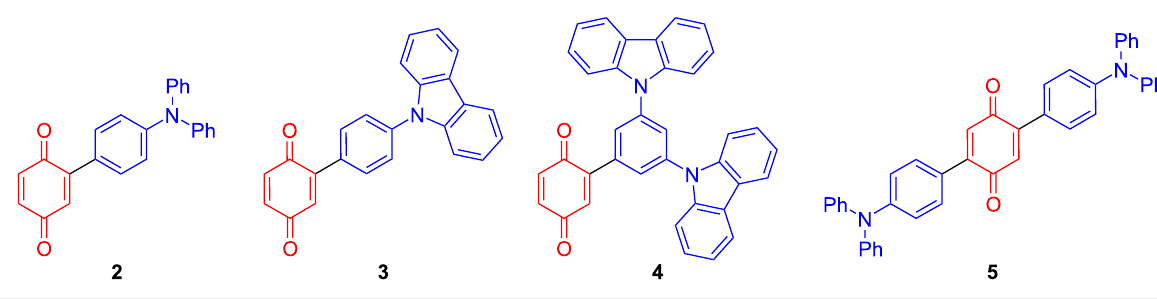
Figure 1: Benzoquinone derivatives synthesized for this study, with the donor in red and the benzoquinone acceptor in blue.